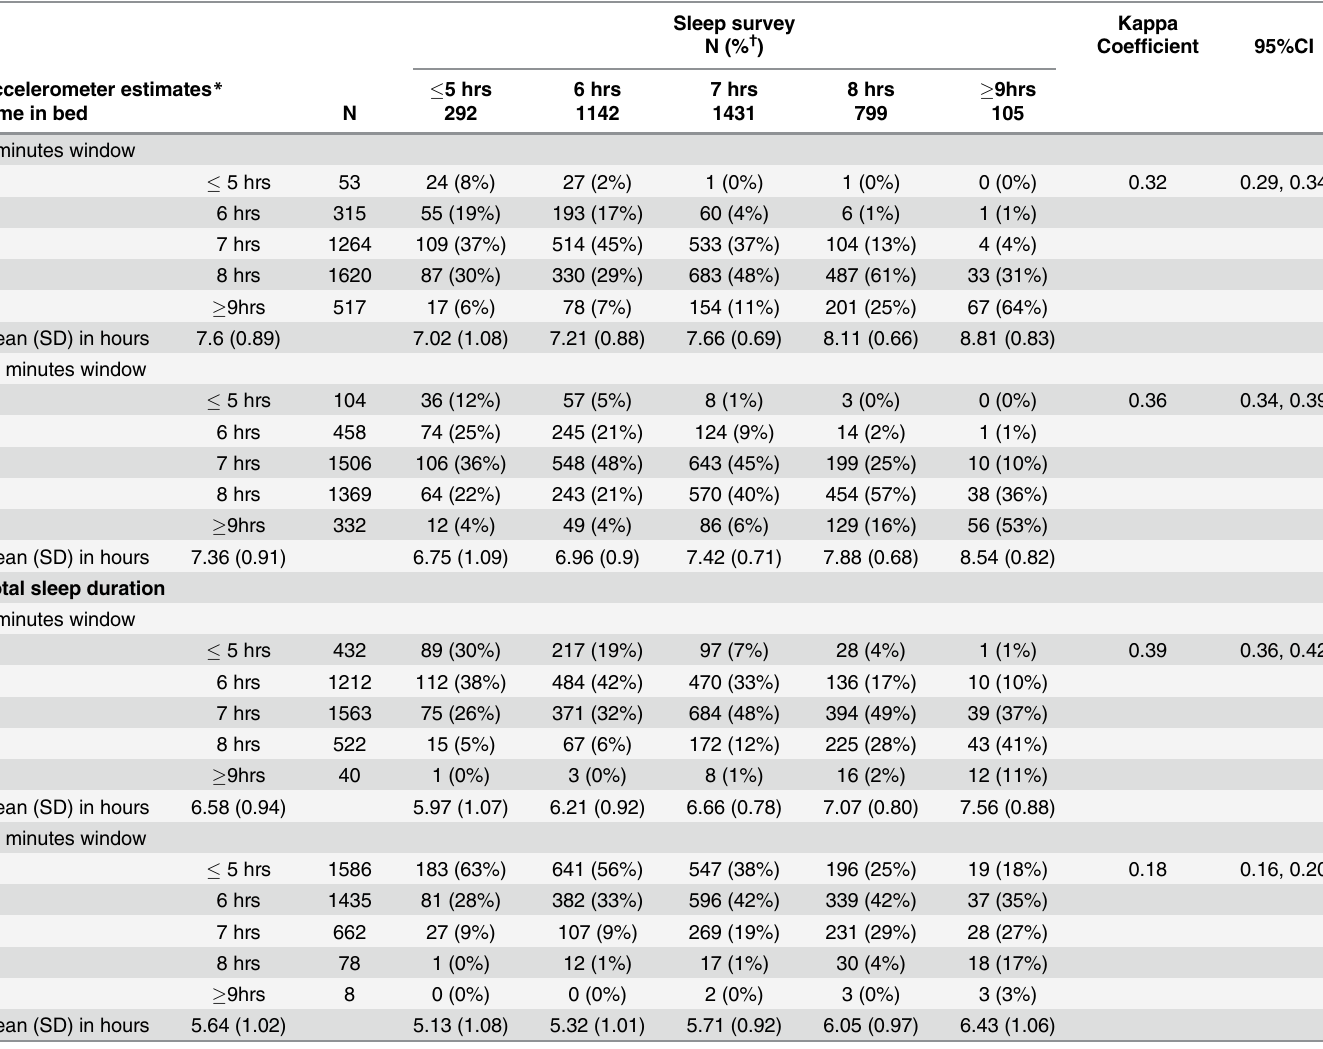
Table 1. Agreement between sleep duration categories estimated by sleep survey questionnaire and by accelerometer methods.